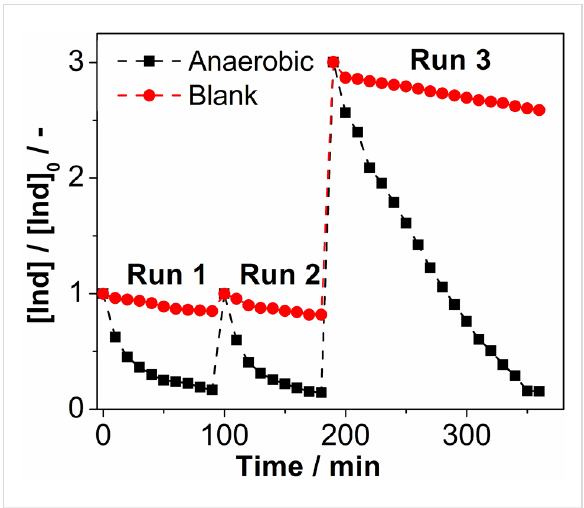
Figure 5: Recyclability of 1 as a homogeneous indigo photooxidation catalyst under anaerobic conditions. Run 1 and run 2 were performed at [Ind] 0 :[1] = 5:1, in run 3, the [Ind] 0 :[1] ratio was increased to 15:1. Solvent: DMF (anaerobic), light source: monochromatic LED ( λ = 430 nm, P nominal = 3